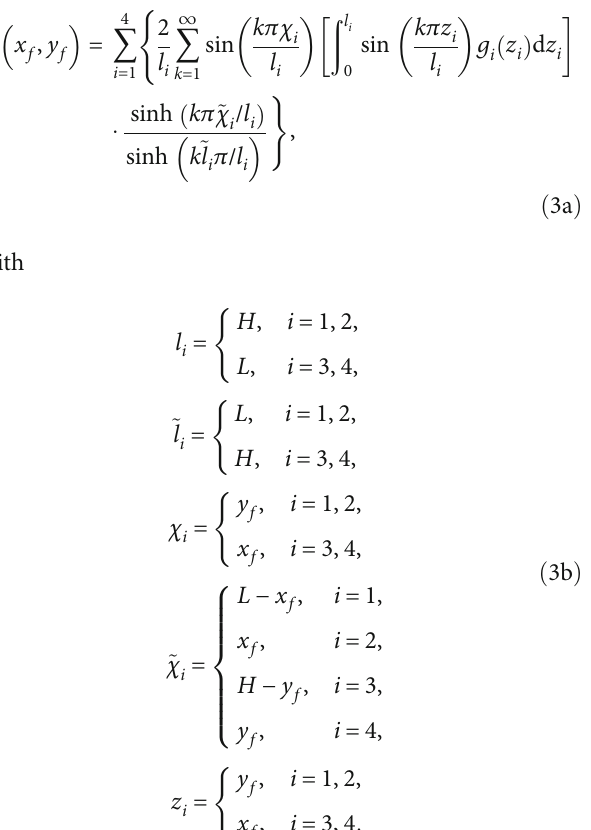
ð i = 1, 2, 3, 4 Þ where i